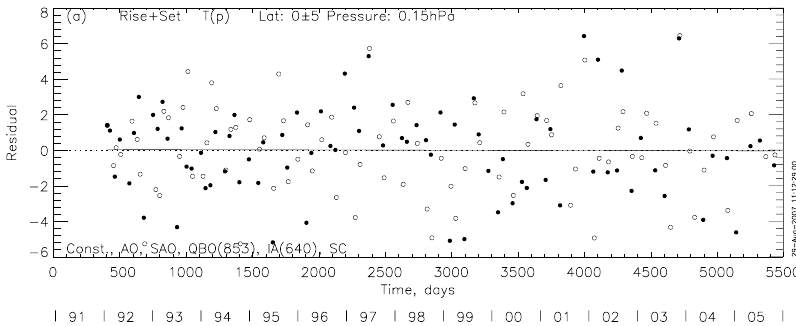
Fig. 3. Temperature residuals (K) for the MLR model fit to the data of Fig.